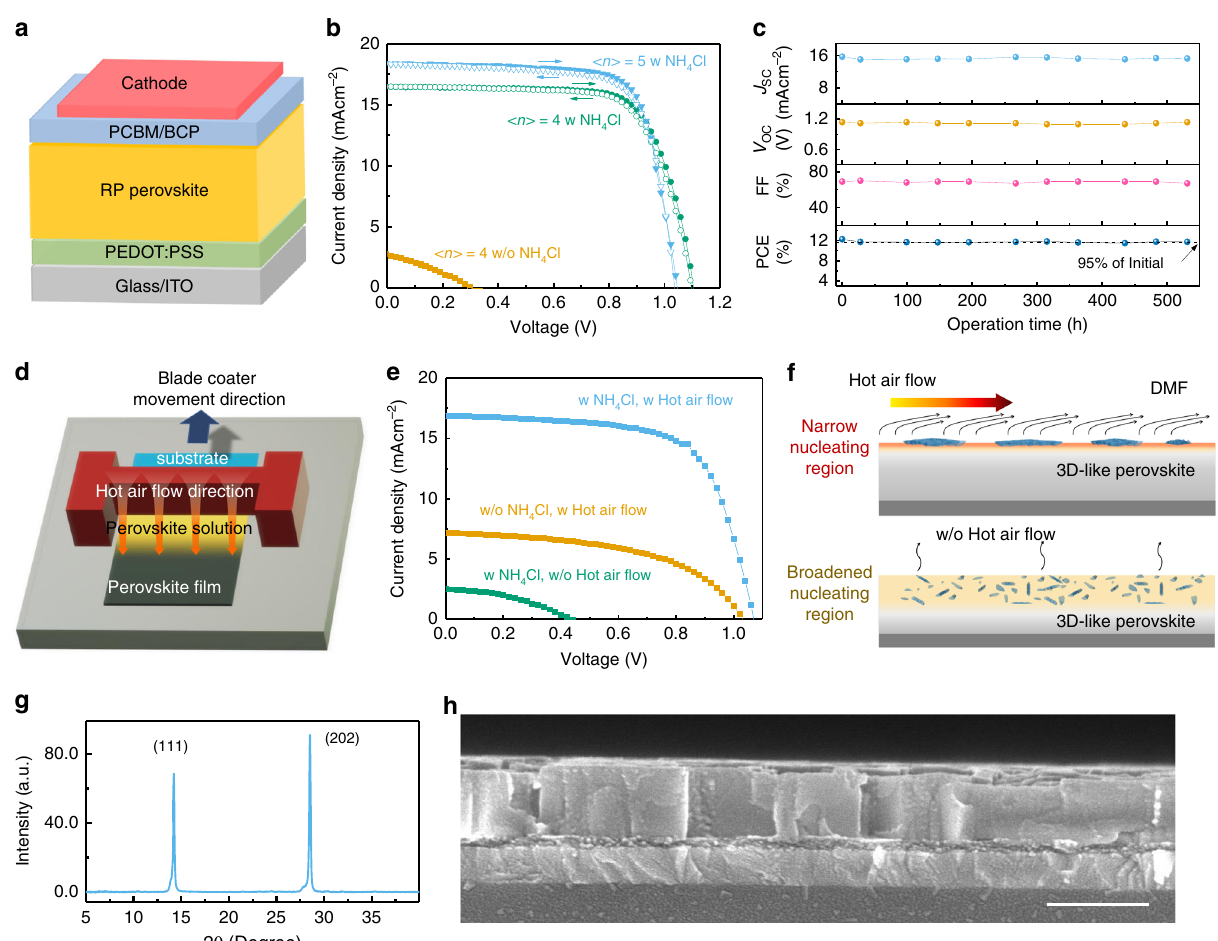
Fig. 5 Achieving OP orientation in doctor bladed RP perovskite fi lms. a Scheme of the structure of RPSCs. b Comparison of current density ( J )-voltage ( V ) curves of RPSCs (under 100 mW cm − 2 AM1.5 G illumination) without and with NH 4 Cl additive, in which RPSCs with < n > = 4 or 5 (with NH 4 Cl) are shown. c Output parameters of BA-based RPSCs as a function of continuous operation time (aged under one-sun, 100 mWcm − 2 , with a loading resistance of 1000 ohm); d illustration of doctor blading setup with RT substrate, precursor solution and available hot air fl ow. e Comparison of J-V curves of RPSCs fabricated from doctor blading with and without NH 4 Cl additive and hot air fl ow. f Illustration of the hot air fl ow induced narrow 3D-like perovskites formation region on the liquid surface and the slow evaporation (w/o hot air fl ow) induced 3D-like perovskites dispersion in a broadened region inside the precursor solution. g , h XRD spectrum ( g ) and cross-sectional SEM image ( h ) of doctor bladed RP fi lms (< n > = 4) with NH 4 Cl additive and hot air fl ow co- treatment on ITO/PEDOT:PSS surface. The scale bar is 300